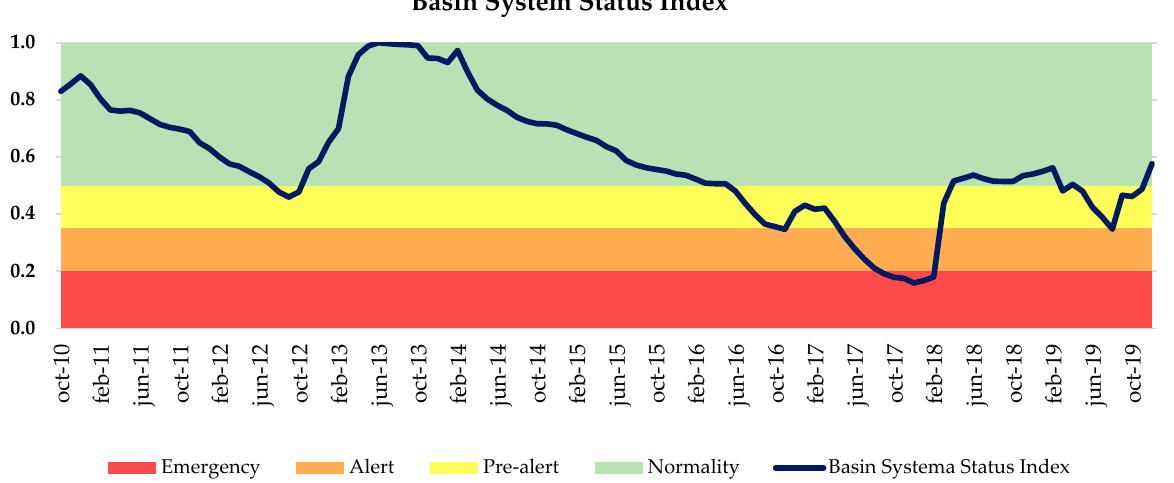
Figure 6. Evolution of the Basin System Status Index, period October 2010-December 2019. Source: own elaboration based on [62].